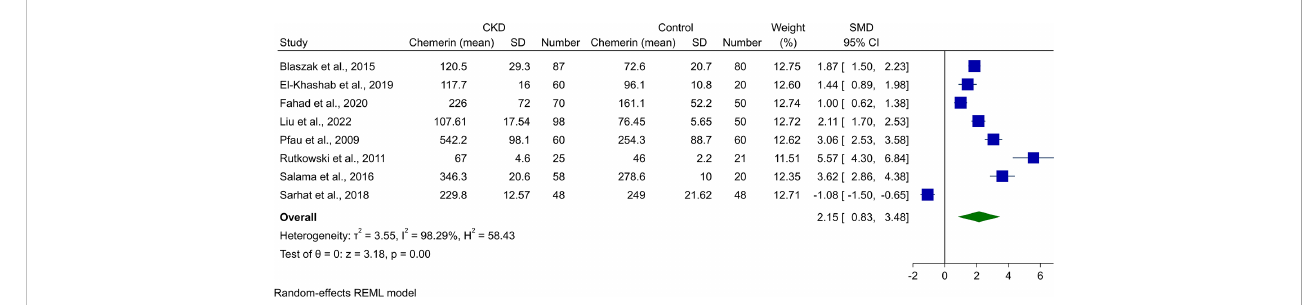
FIGURE 2 Forest plot for meta-analysis of chemerin levels in chronic kidney disease patients compared to